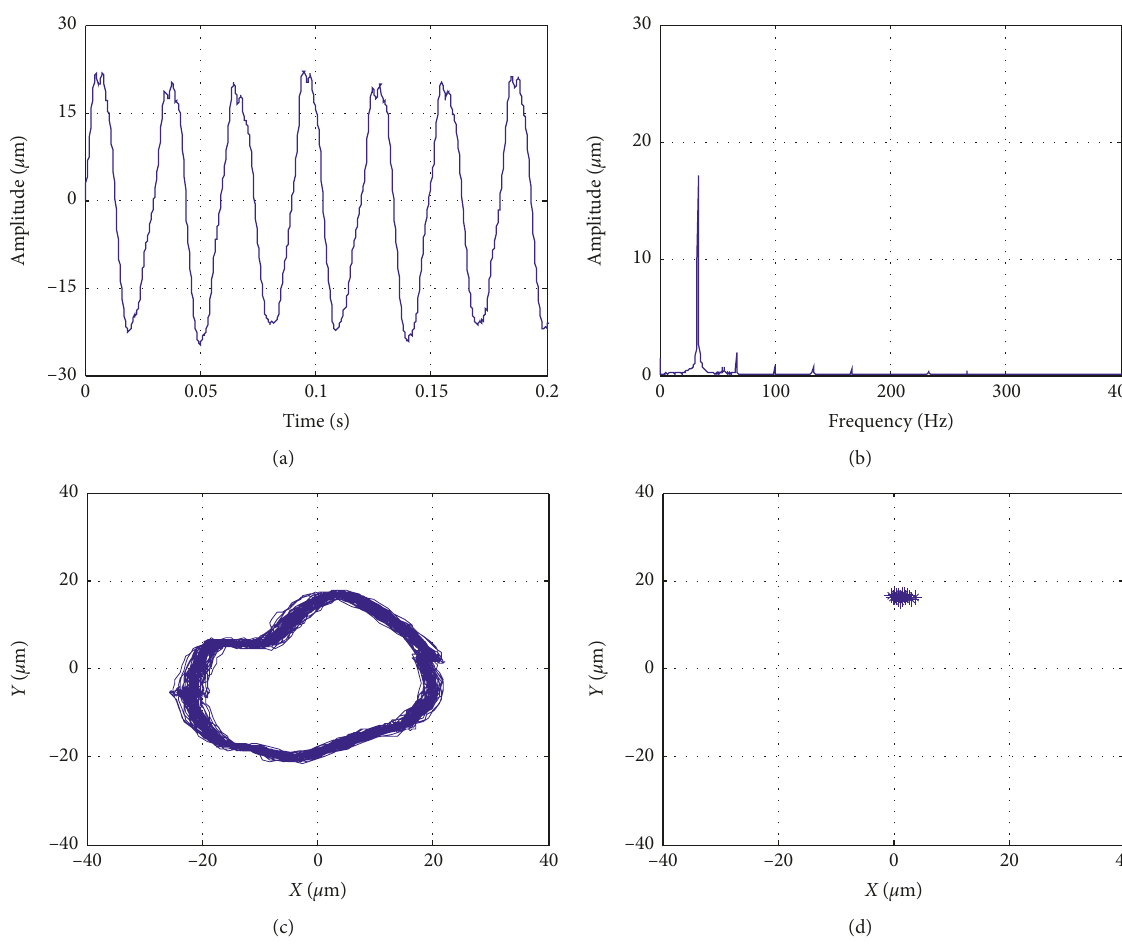
Figure 13: Severe rubbing at 2000r/min. (a) Time-domain waveform. (b) Spectrum graph. (c) Axis orbit. (d) Poincare